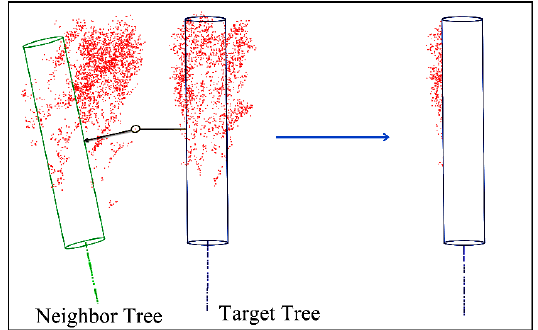
Figure 8. Allocation of points outside of the Deterministic Segment of Individual Trees (DSITs) to their trees. 4.